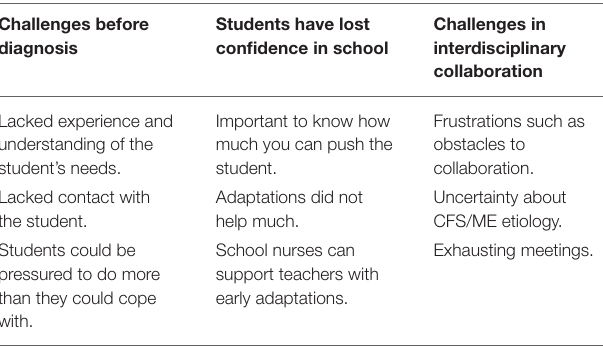
TABLE 3 | Summary of challenges related to adaptation of education and social life at school for young people with CFS/ME. Challenges before